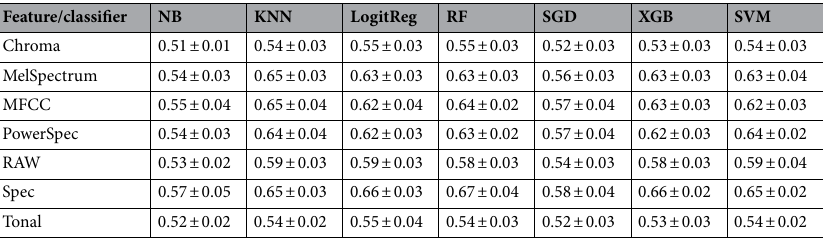
Table 1. Classification accuracy of several shallow machine learning